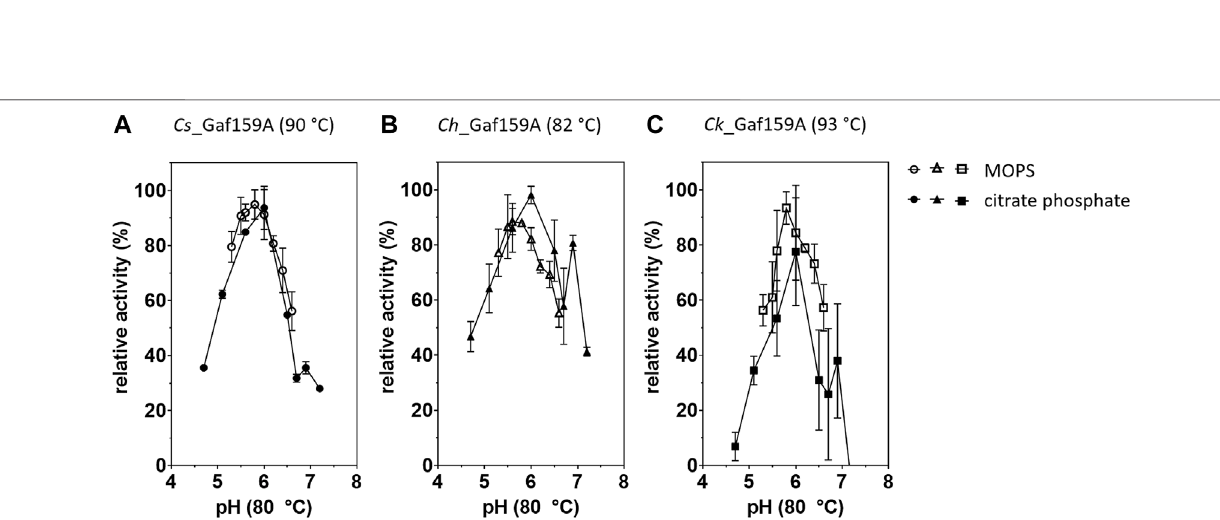
FIGURE 5 | In fl uence of different pH values on the activity of Cs -, Ch - and Ck _Gaf159A. Reactions contained either McIlvaine ( fi lled symbols), or MOPS buffer (empty symbols), 2.65 µM enzyme (0.1 µg μ l − 1 ), 1 mM pNPA, 1 x RP and 1 mM CaCl 2 and were incubated for 20 min at the respective temperature optimum. (A) Cs _Gaf159A,90 ° C; (B) Ch _Gaf159A,82 ° C; (C) Ck _Gaf159A, 93 ° C.Activitiesare related tohighestactivity withtherespectivebuffer. Barsrepresentstandarddeviation from